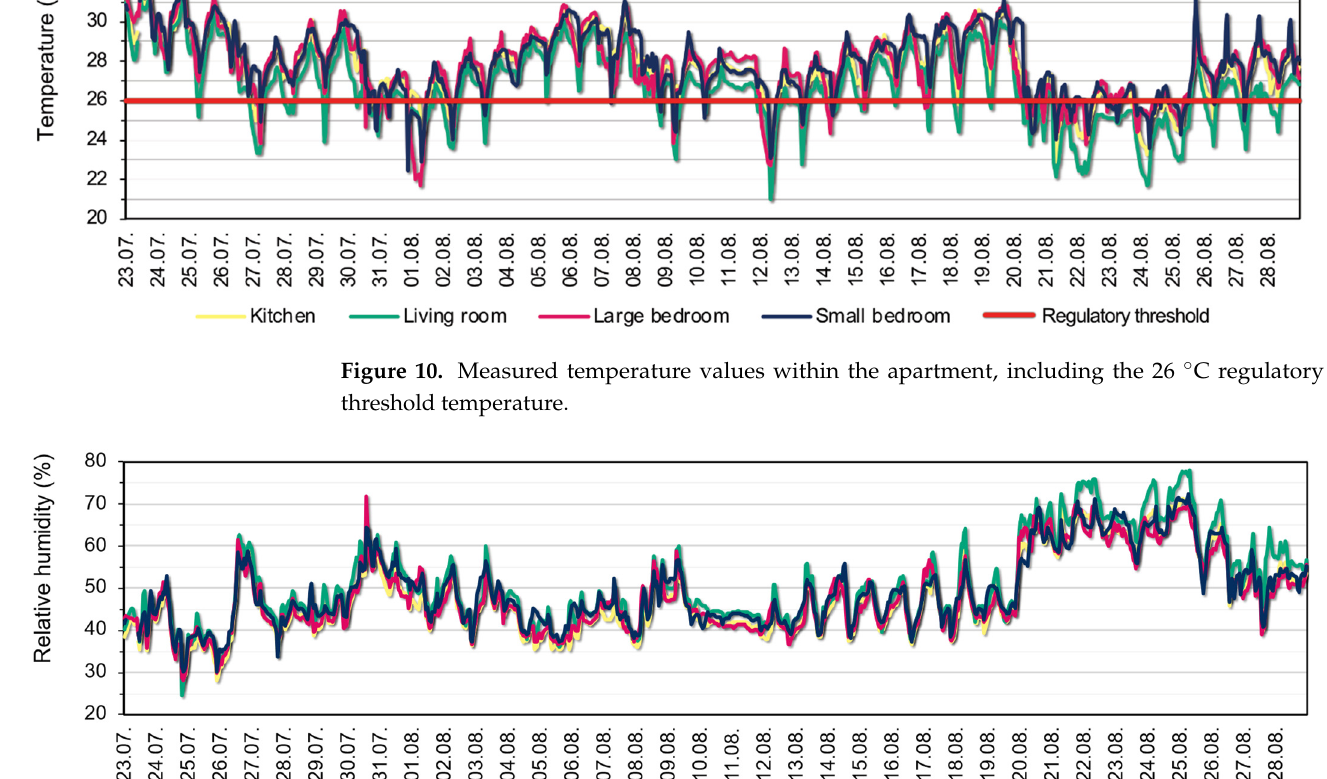
Figure 11. Measured relative humidity values within the apartment.